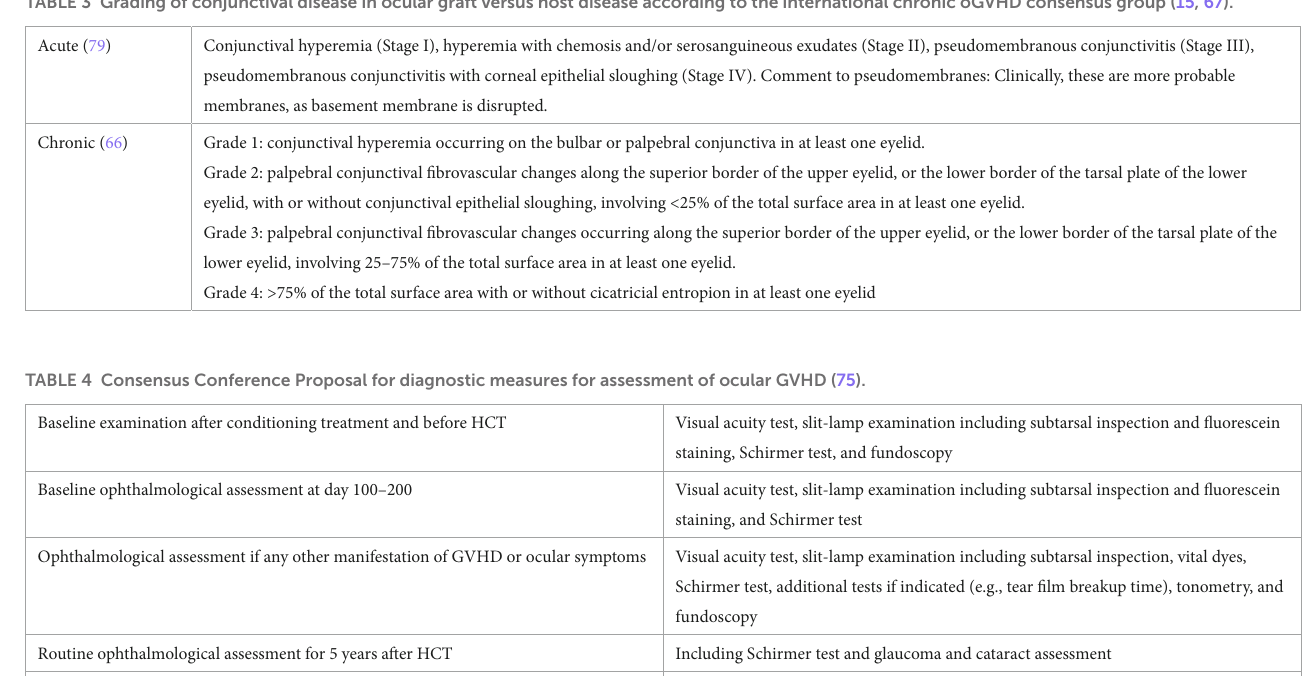
TABLE 3 Grading of conjunctival disease in ocular graft versus host disease according to the international chronic oGVHD consensus group (15, 67). Acute (79) Conjunctival hyperemia (Stage I), hyperemia with chemosis and/or serosanguineous exudates (Stage II), pseudomembranous conjunctivitis (Stage III), pseudomembranous conjunctivitis with corneal epithelial sloughing (Stage IV). Comment to pseudomembranes: Clinically, these are more probable membranes, as basement membrane is disrupted.